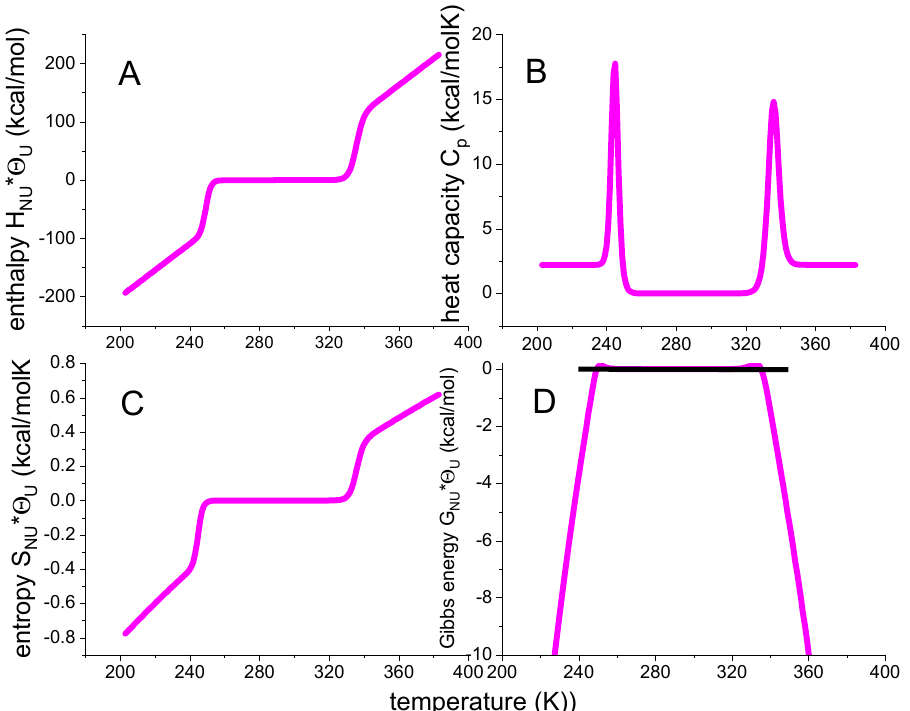
The Equation (12) for the heat capacity is not repeated here. The resulting temperature profiles are shown in Figure 3.